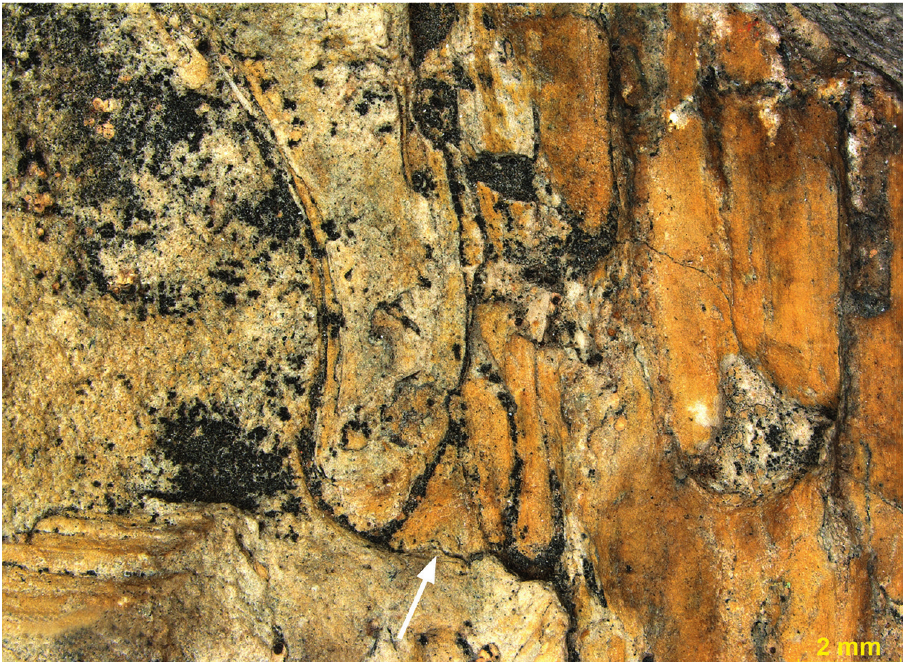
Figure 2. Side view of leaf attachment: sample 191, Mt Pelé. (Arrow indicates leaf